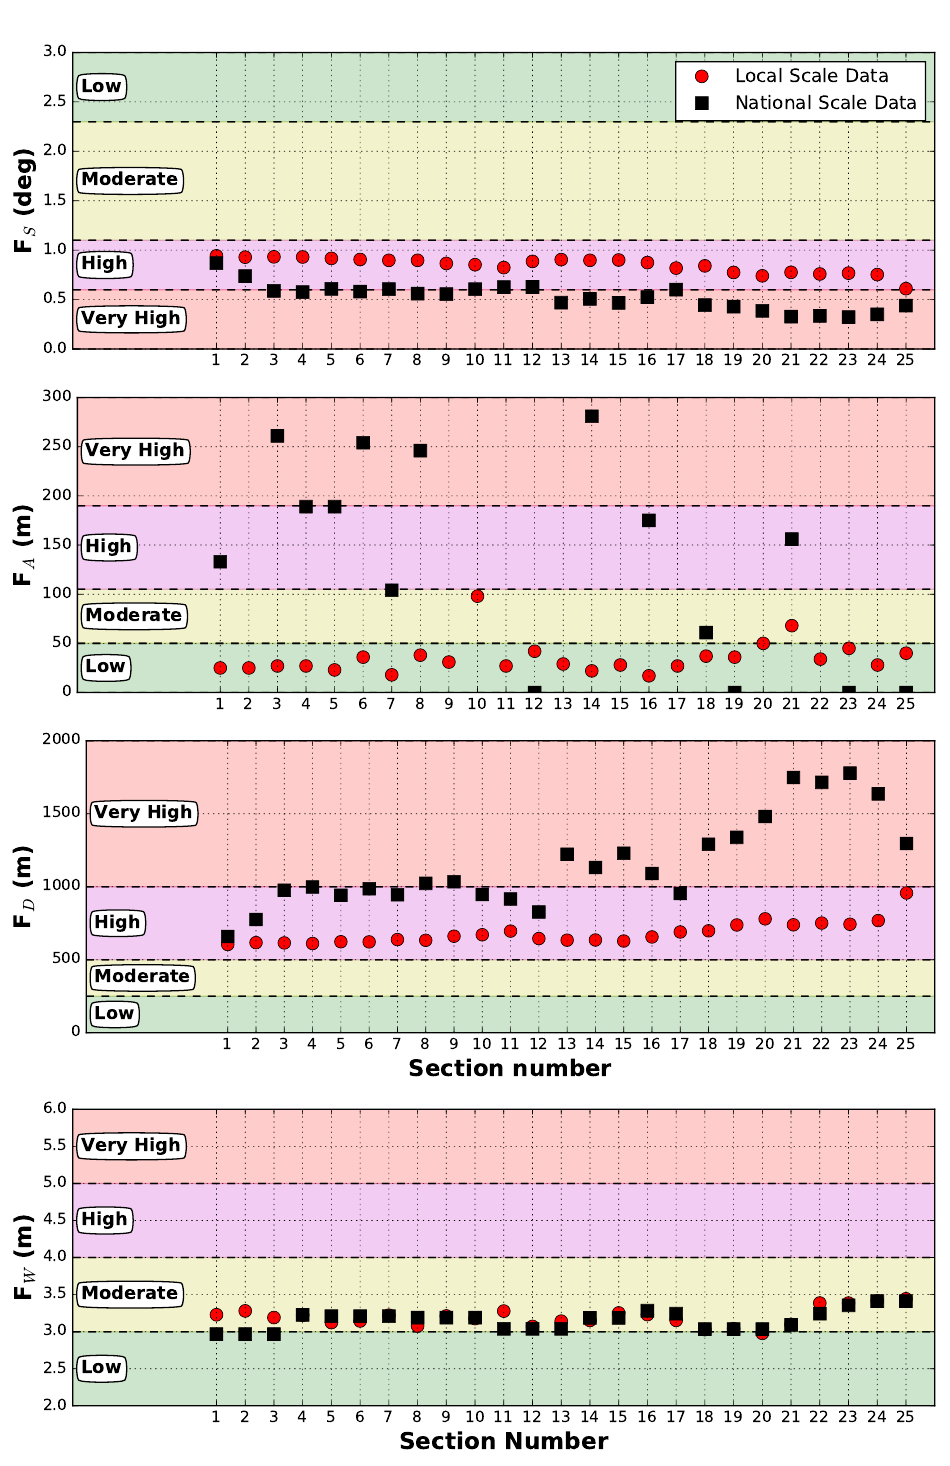
Figure 5. Factors for the Coastal Vulnerability Index (CVI) assessment. From the upper panel to the lower panel: F S (slope of submerged beach), F A (extension of the flooded area), F D (horizontal distance of the reference water depth, i.e., 10 m, from the coastline), F W (mean value of the annual maximum of significant wave height at the nearshore limit) evaluated for each cross-section (the x axis reports the section numbering; see Figures 6–8) along the considered coastal stretch. The shaded areas refer to the vulnerability